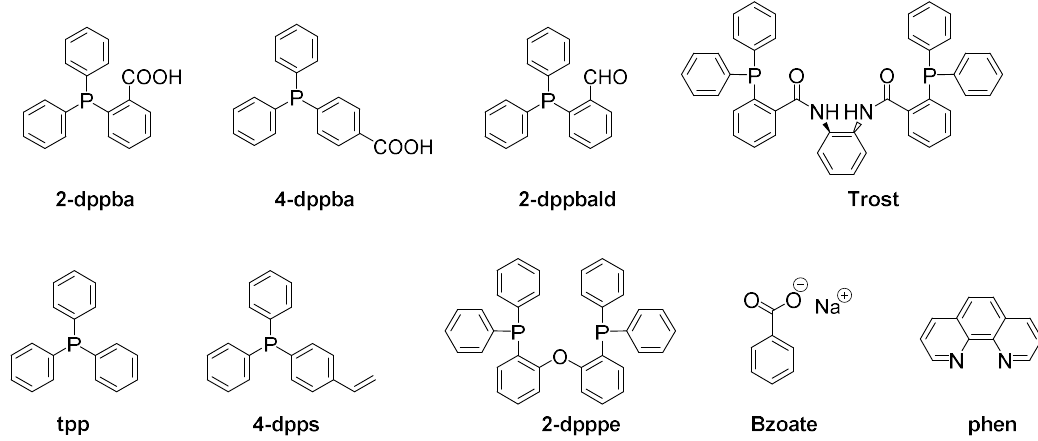
Figure 31. Chemical structures of phosphines used to initiate a ligand exchange with Cu(acac) 2